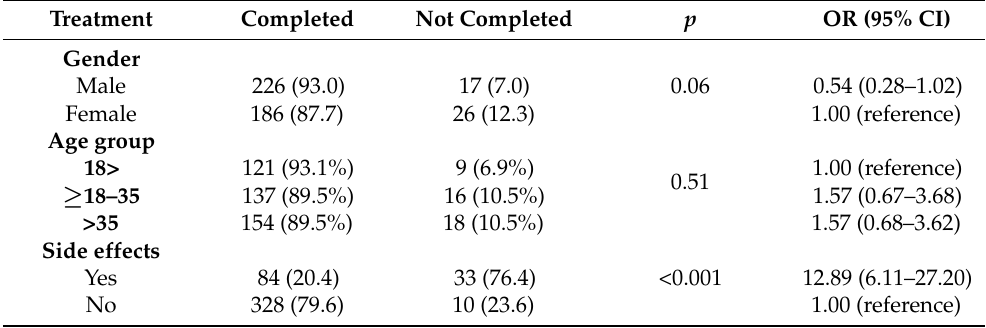
Table 2. Treatment completion by gender, age groups, and adverse drug events among Ethiopian Immigrants.